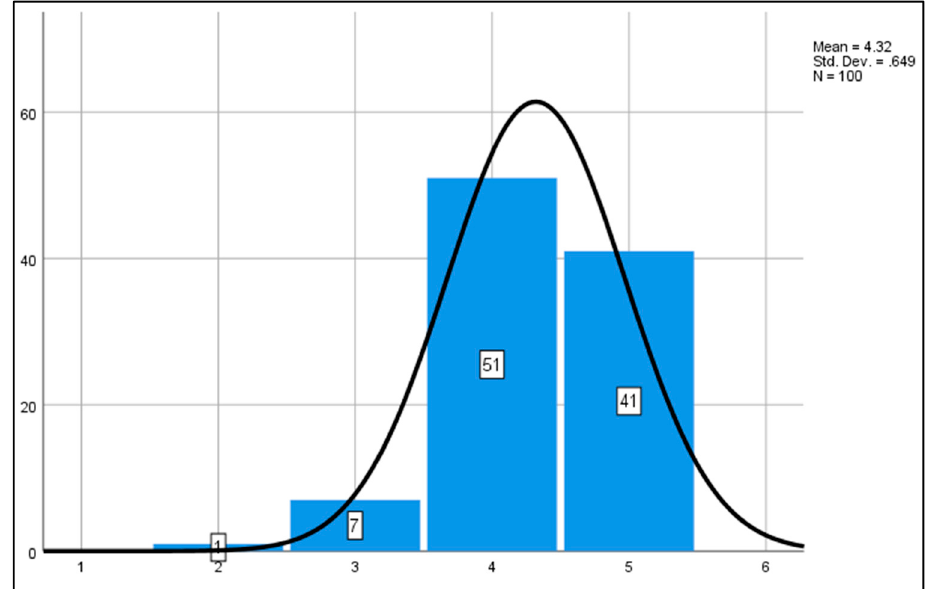
Figure 12 . Motivation and Industry 4.0 readiness.